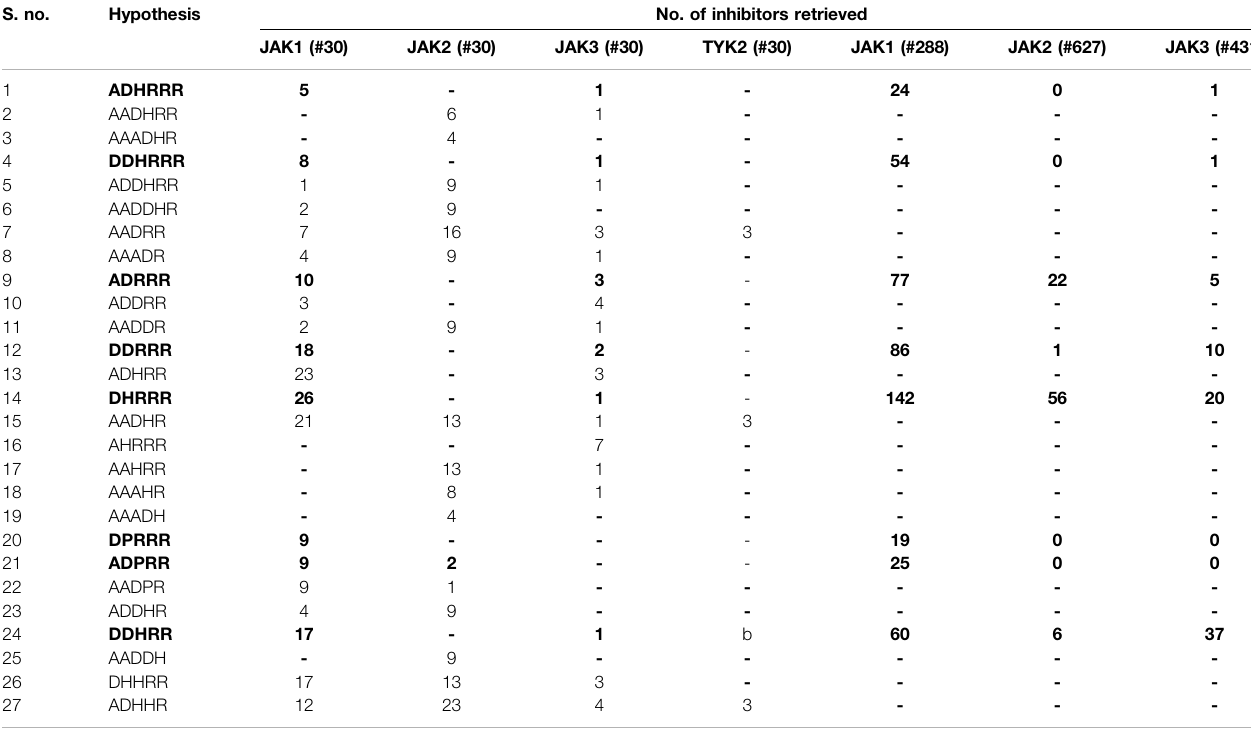
TABLE 4 | Pharmacophore validation results from selectivity